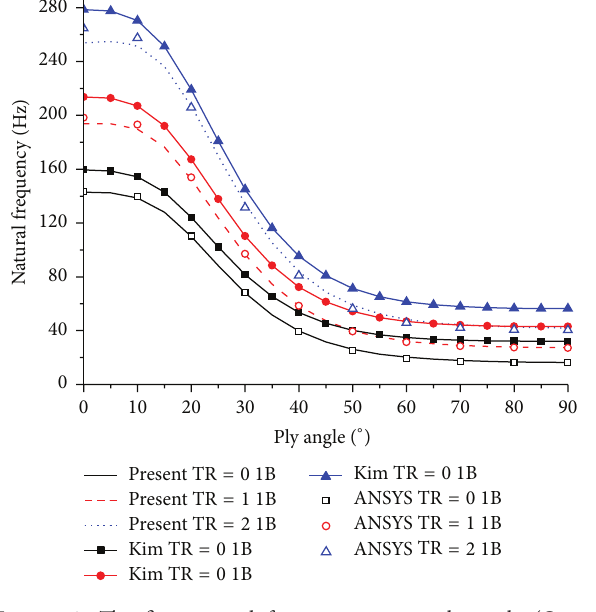
Figure 9: The first natural frequency versus ply angle ( Ω = 100 rad/s).